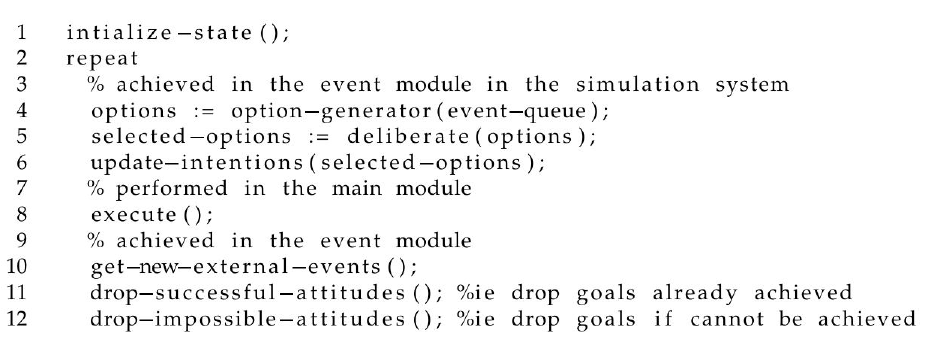
Figure 1. BDI interpreter cycle